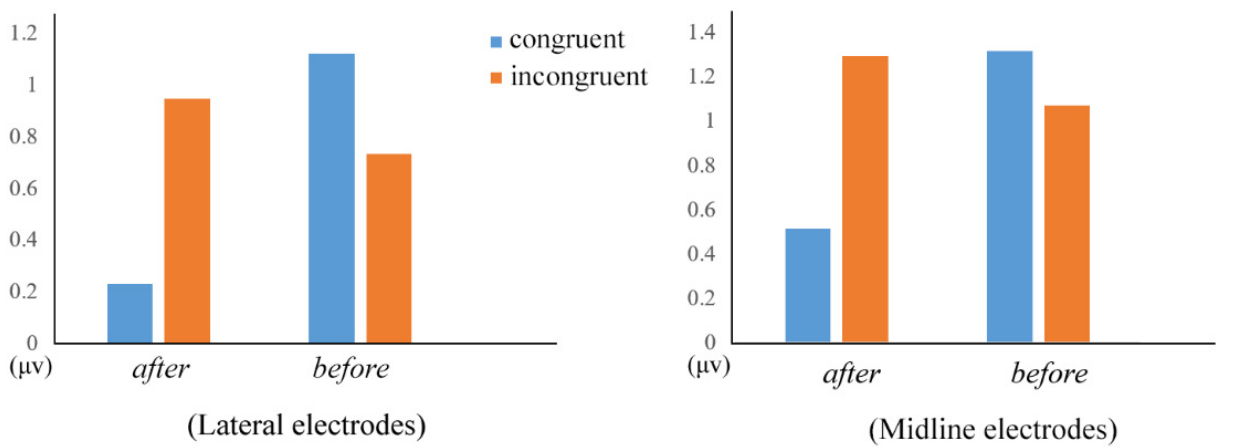
Figure 3. The bar plots for the average P600 amplitude (300–800 ms) of the critical words in each experimental condition in lateral analysis (left) and midline analysis (right).